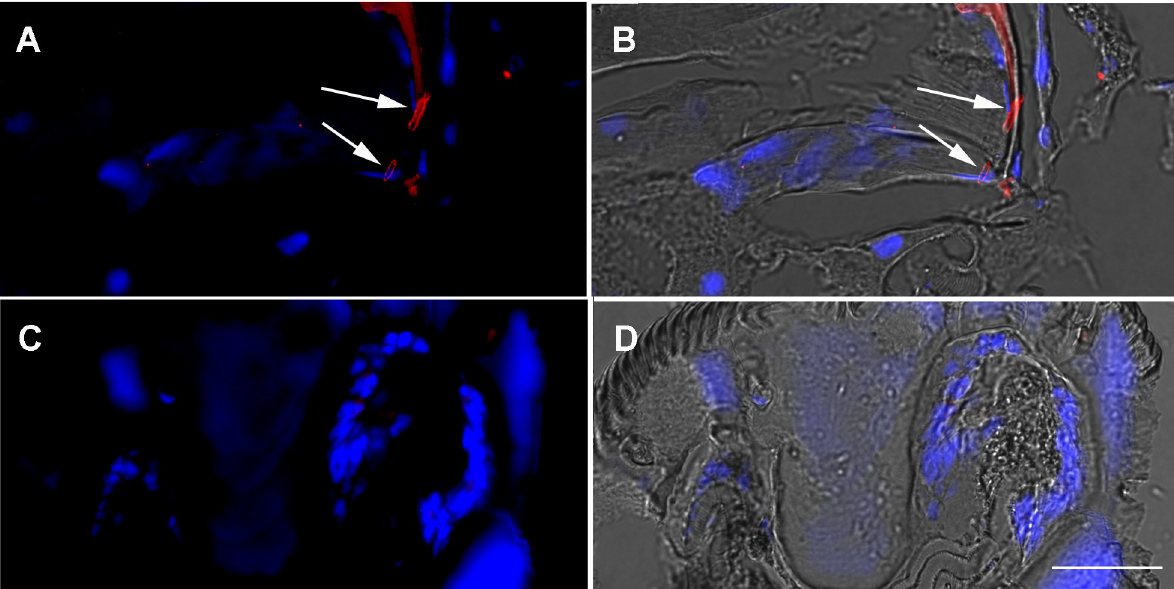
Fig 4. Immunolocalization of Mycobacterium LAM cell wall antigen in Amblyomma sculptum larvae. Larvae that hatched from eggs laid by A . sculptum females after artificial feeding with uninfected (C, D) or M . leprae -infected (A, B) rabbit blood were fixed and sectioned. Panels A and C were generated through merging red channel image (anti-LAM + anti-mouse Alexa 594) with blue channel image (DAPI nuclear staining). Panels B and D were generated by merging with differential interference contrast images. Small numbers of mycobacteria (arrows) can be seen inside the digestive tract of larvae derived from infected females. Images representative of nineteen larvae observed in three independent biological replicates. Scale bar represents